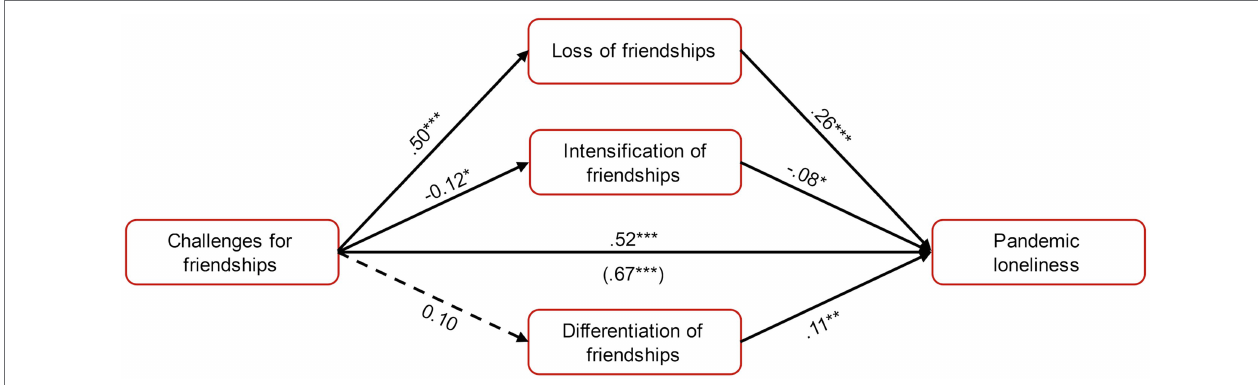
FIGURE 4 | Mediation model for challenges for and changes in friendships. Dotted lines represent non-significant effects. *** p < 0.001, ** p < 0.01, * p <